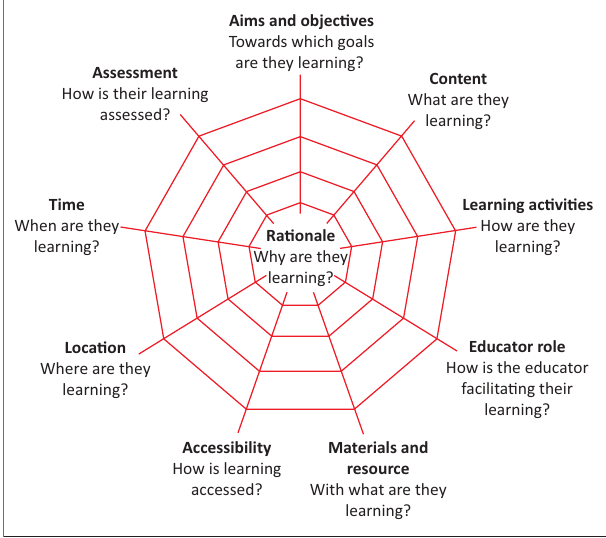
FIGURE 1: Curricular spider